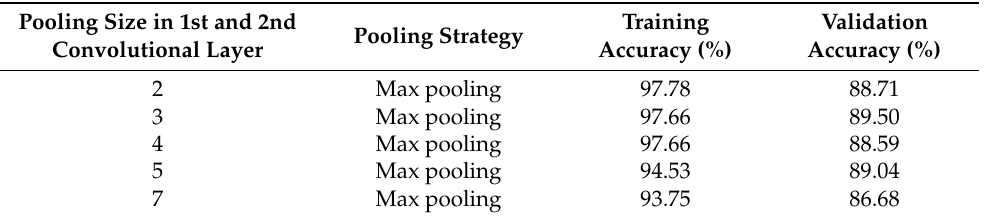
Table 6. Training and validation accuracy for different pooling sizes.